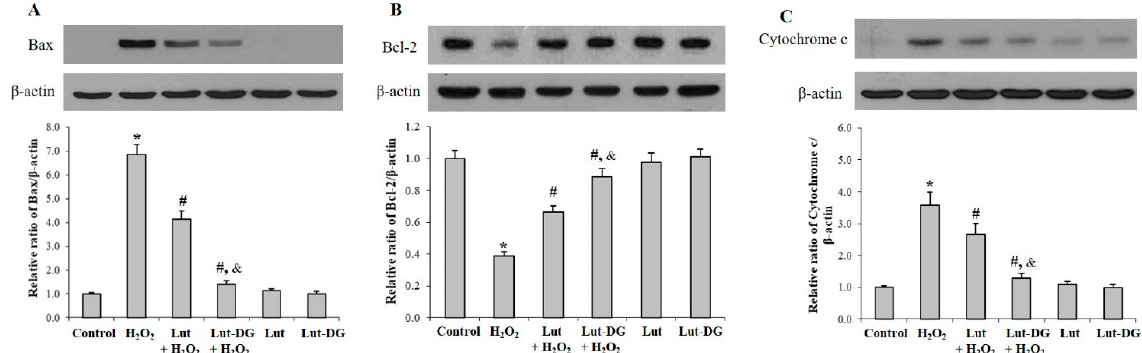
Figure 6. Protective effects of Lut and Lut-DG against oxidative stress occurs through modulation of apoptotic regulatory molecules Bax, Bcl-2 and Cytochrome c. ARPE-19 cells were pre-treated with 1 µM Lut and Lut-DG for 24 h, followed by H 2 O 2 treatment at 400 µM for 1 h. Protein levels of ( A ) Bax, ( B ) Bcl2 and ( C ) Cytochrome c were evaluated by immunoblotting. β -actin immunodetection was used as a loading control. Representative western blots are shown, with graphs presenting average normalized protein expression. Data is presented as mean ± SD values, n = 4; (One-Way ANOVA test), * p ≤ 0.05 vs. control group, # p ≤ 0.05 vs. H 2 O 2 group, and & p ≤ 0.05 vs. Lut + H 2 O 2 group).